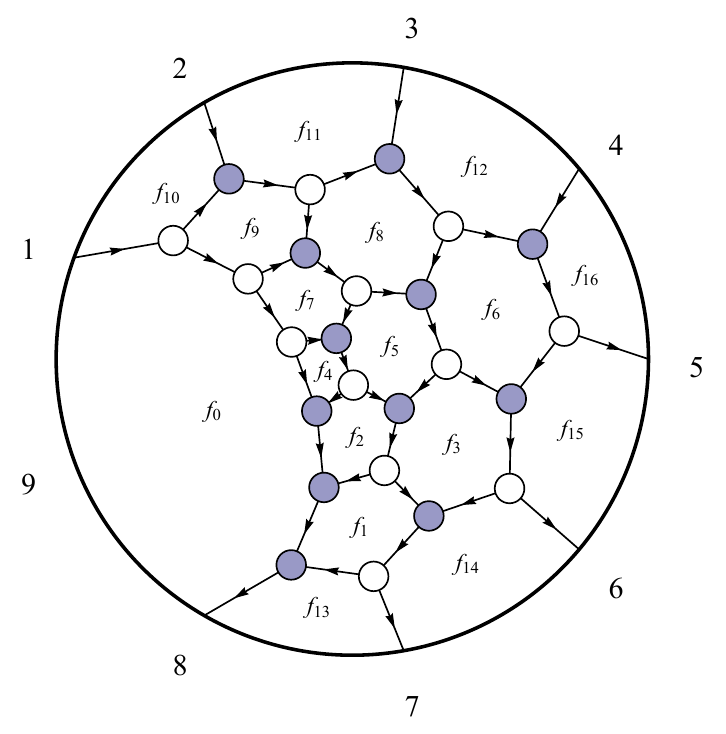
Figure 1 . A plabic graph associated to the top cell of G + (4 , 8)